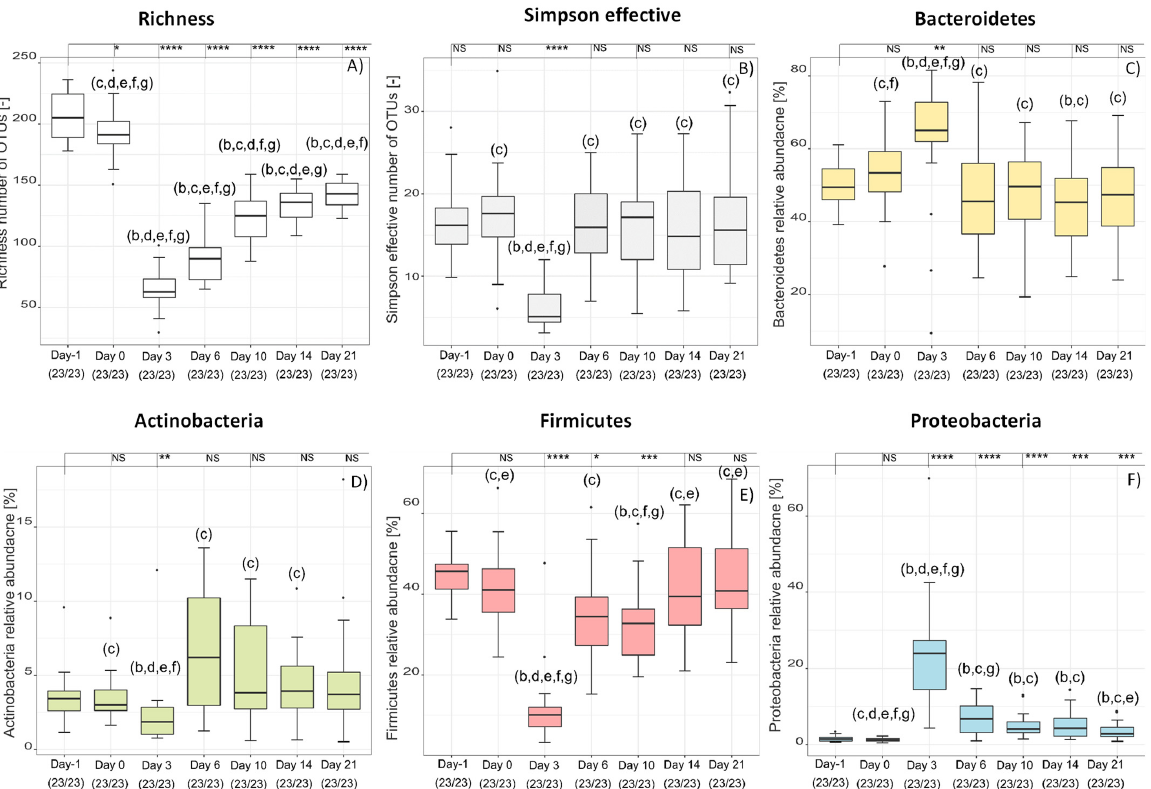
Figure 5. Richness ( A ), Simpson effective index ( B ) and relative abundance at phylum level of Bacteroidetes ( C ), Actinobacteria ( D ), Firmicutes ( E ), Proteobacteria ( F ) of the 23 hamster that survived due to the treatment with anti-CD-WPI (WPI 100, 1000, 10,000). Significance values are p < 0.05 = *, p < 0.01 = **, p < 0.001 = ***, p < 0.001 = ****, NS = not significant. Given significance values are in comparison to before treatment, significant differences between the groups are marked by small letters.